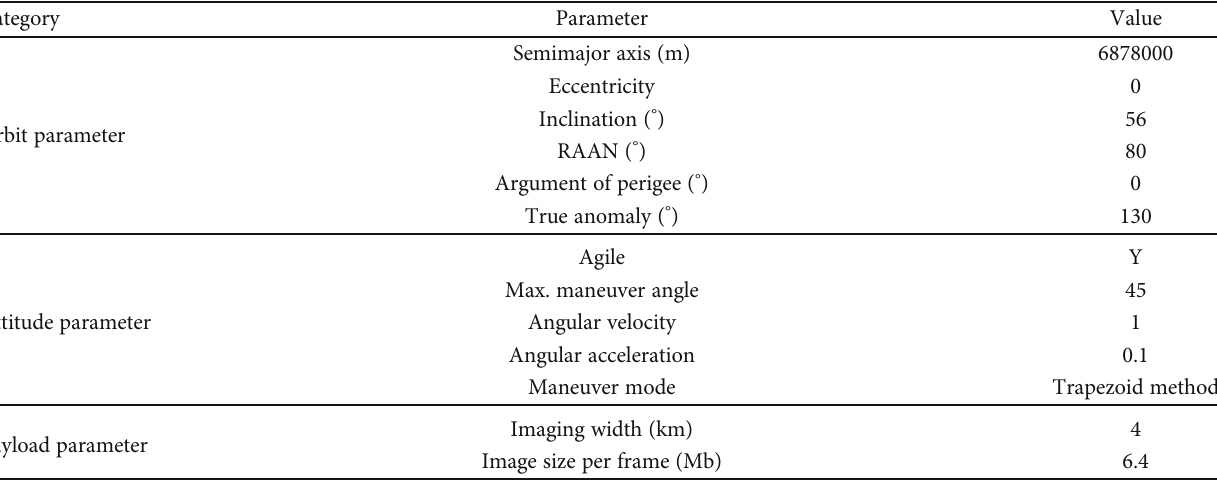
Table 2: Parameters for satellite